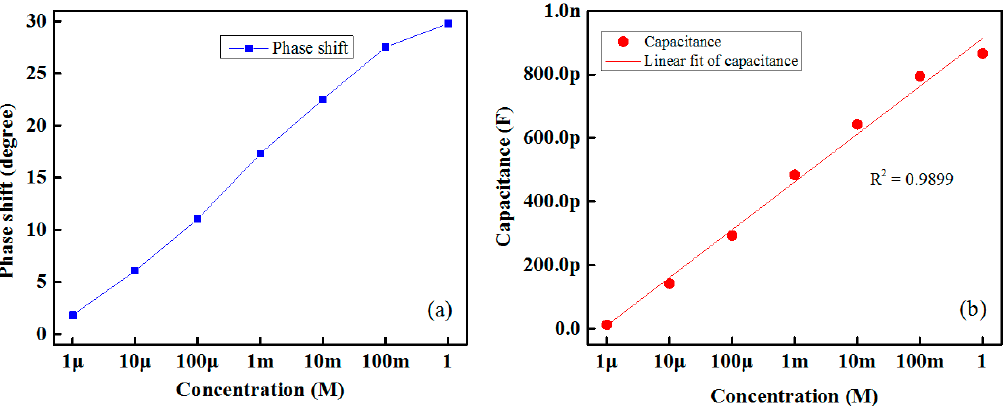
Figure 6. Response of the designed IDC glucose biosensing system: ( a ) change in phase shift of different concentrations of glucose solution; and ( b ) variation in the capacitance.